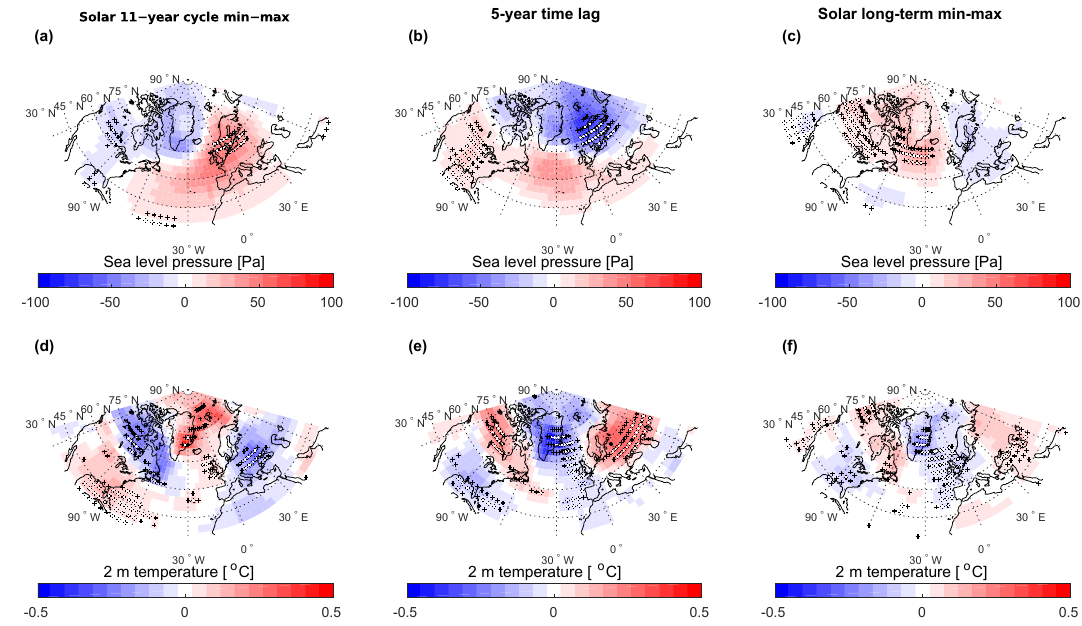
Figure 5. Reconstructed atmospheric response to solar forcing. (a) DJF SLP anomalies (Pa) in response to the 11-year solar cycle (solar min. minus solar max. defined in Fig. S10). (b) DJF SLP anomalies (Pa) in response to the 5-year lagged 11-year solar cycle (solar min. minus solar max.). (c) DJF SLP anomalies (Pa) in response to the long-term solar forcing (solar min. minus solar max. defined in Fig. S11). (d, e, f) corresponding figures to (a, b, c) , but for T2m ( ◦ C). The white stippling indicates significant anomalies p < 0 . 05, and black stippling indicates significant anomalies p < 0 . 1 (two-tailed Student’s t test). Table 4. Correlation between solar forcing and PC2 of SLP, with and without time lag. The first column indicates which data are used, and if any filtering is done to the data. The second column is correlation coefficients between solar forcing and PC2 of reconstructed SLP, with solar forcing either being represented by sunspot number or 14 C data. The third column is correlation coefficients between solar forcing and PC2 of reconstructed SLP, with solar forcing represented by sunspot number shifted for a lag of 5 years. All correlations are for detrended data, and p values are calculated with the random-phase test by Ebisuzaki (1997) to take into account autocorrelation. No time